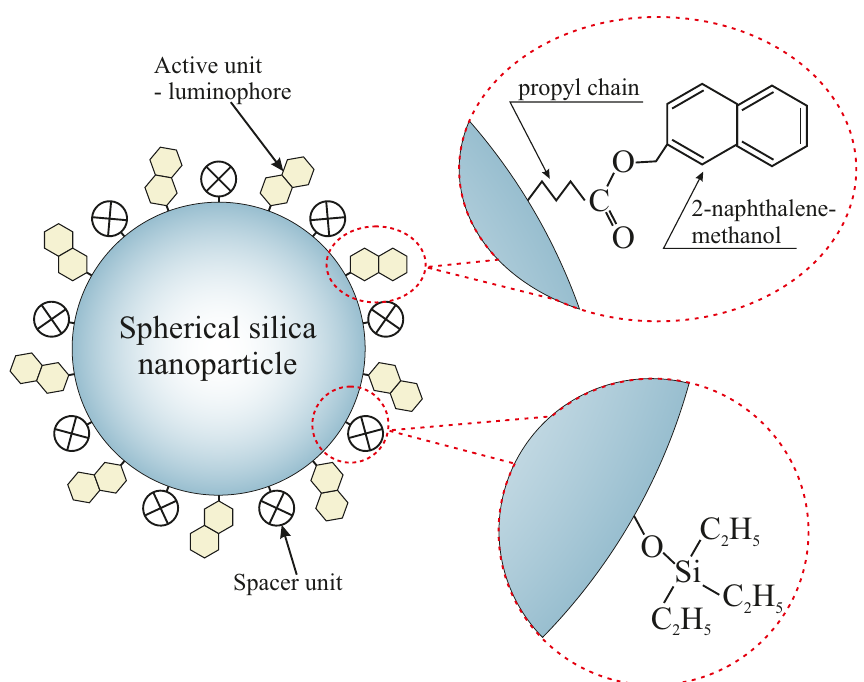
Figure 1. The scheme of a spherical silica functionalized by 2-naphthalene methanol with designed inter-molecular distances. The spacer units play a role as separators between functional